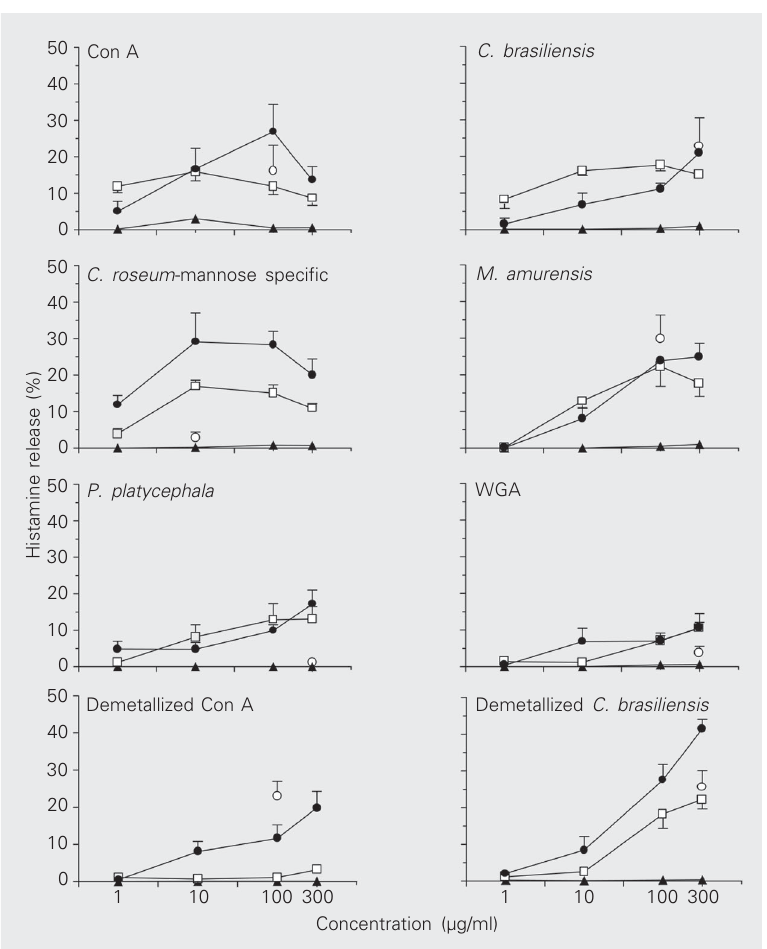
Figure 1. Lectin-induced histamine release from mast cell suspensions from Wistar rat peritoneal cavity (filled circles), hamster cheek pouch (squares), guinea pig intestine (tri- angles), and Rowett nude rat peritoneal cavity (open circles). The points indicate the means and the bars the respective SEM for 3-9 experiments. Some SEM were omitted to improve visualization of the